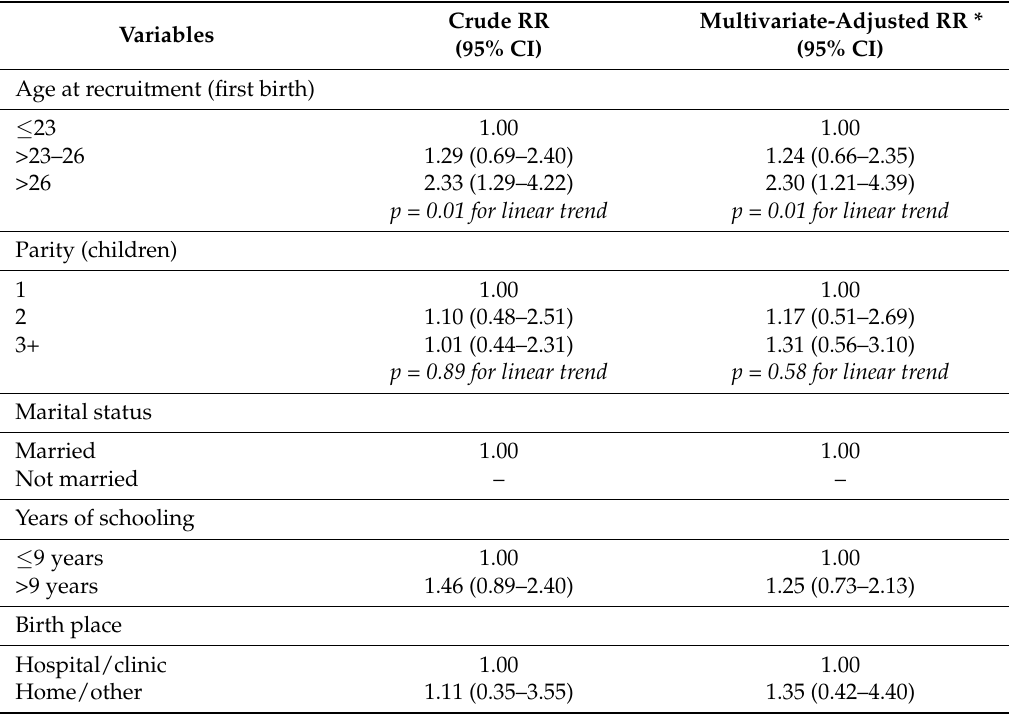
Table 2. Association between parity, age at first birth, and relative risk of death from bladder cancer over a 32-year follow-up